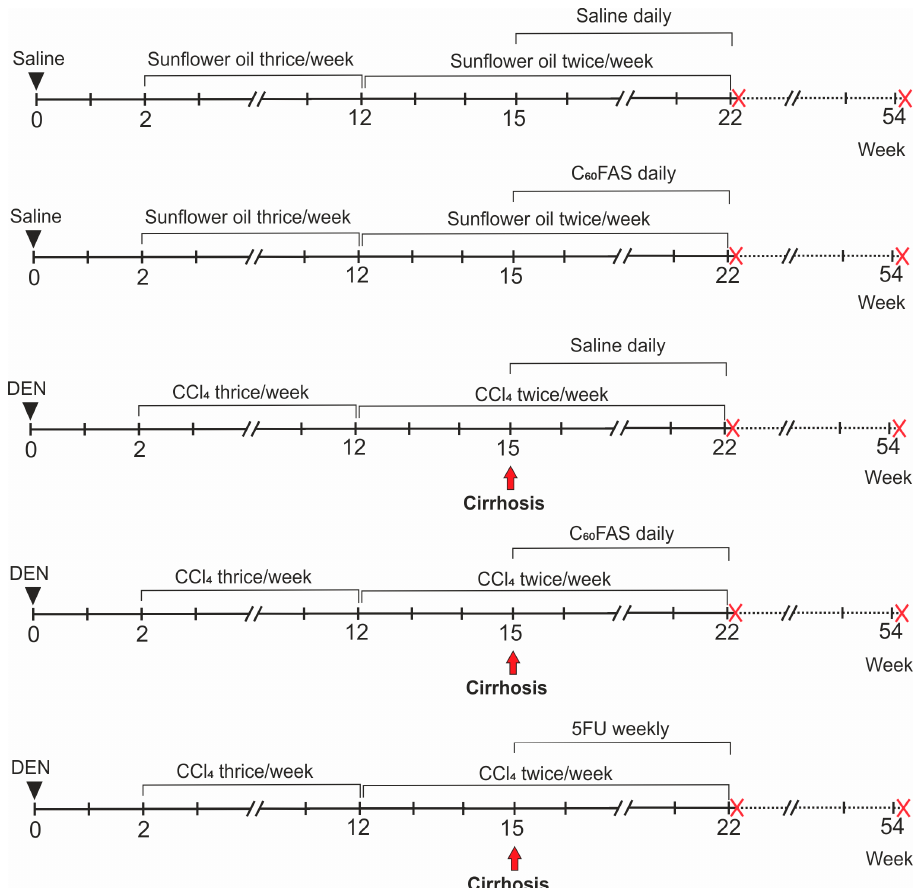
Figure 1. The scheme of the experiment. Experimental groups were as follows (from top to bottom): Control (n = 16); C 60 FAS (n = 16); HCC (n = 16); HCC + C 60 FAS (n = 16); HCC + 5FU (n = 16). Doses and solvents: DEN—200 mg / kg in saline (total volume 0.1 mL), CCl 4 —1 mL / kg in sunflower oil (total volume 0.2–0.7 mL depending on body weight), C 60 FAS—0.25 mg / kg (0.3–0.6 mL depending on body weight), 5FU—15 mg / kg in saline (total volume 0.1 mL), saline—0.1 mL (instead of DEN and 5FU) or 0.3–0.6 mL (instead of C 60 FAS), sunflower oil—0.2–0.7 mL (instead of CCl 4 ). Halves of each group were sacrificed in 22 weeks from the start of experiment (the first crosses), other halves were left